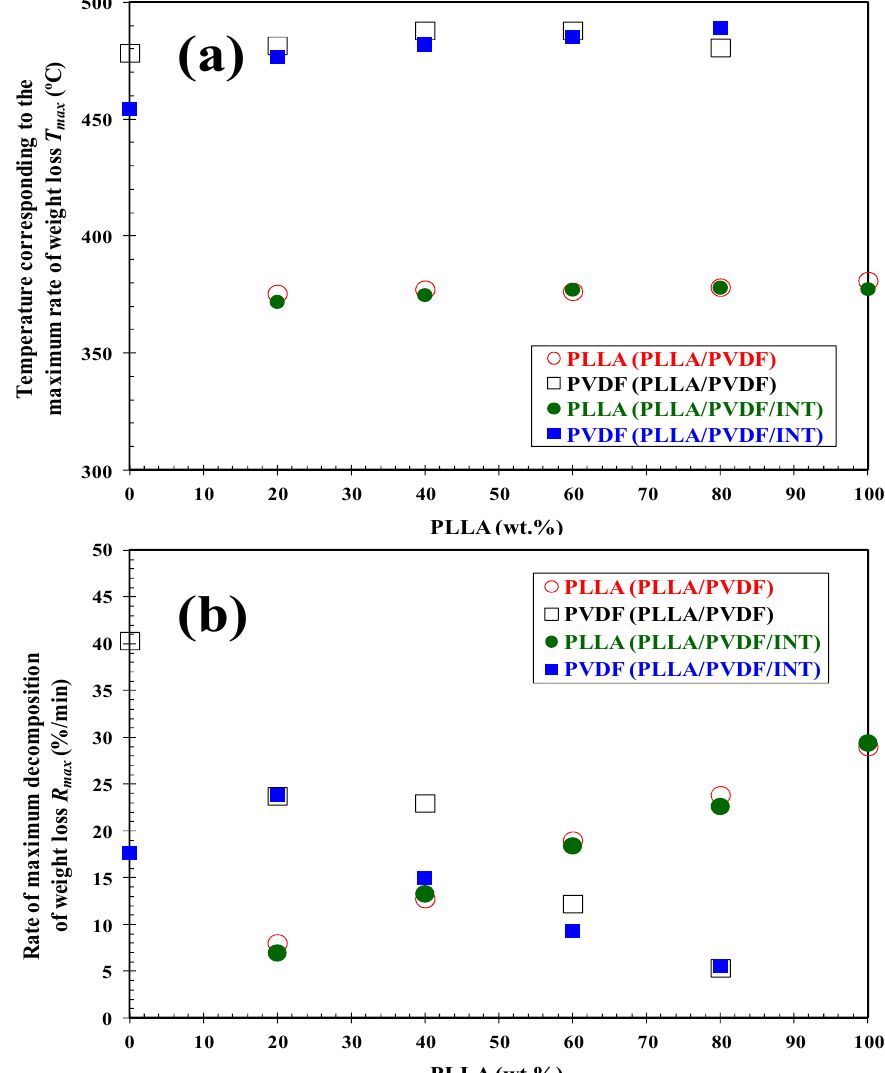
Figure 4. ( a ) Variation of the temperature and ( b ) rate of maximum decomposition ( T max / R max ) of PLLA and PVDF in the binary PLLA/PVDF and ternary PLLA/PVDF/INT-WS2 hybrid nanocom- posites with composition.